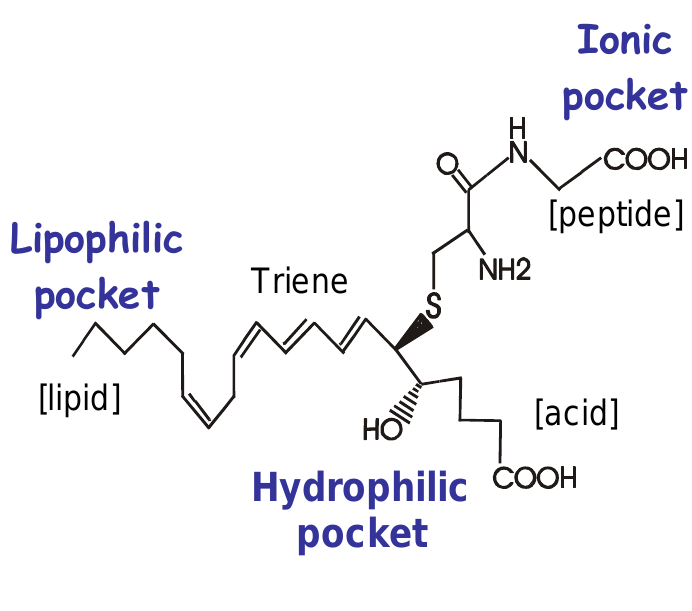
FIGURE 4. Structure of LTD 4